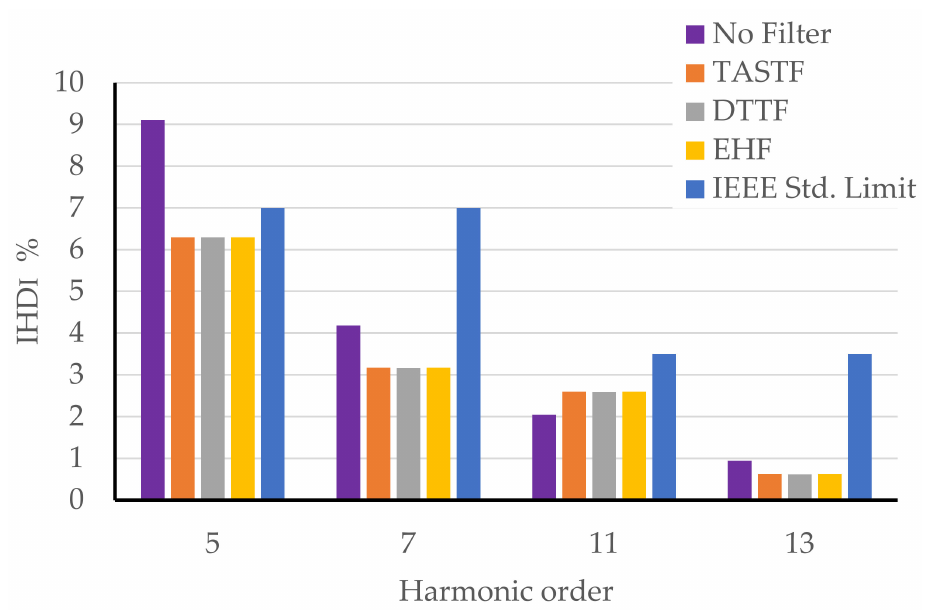
Figure 11. The individual load current